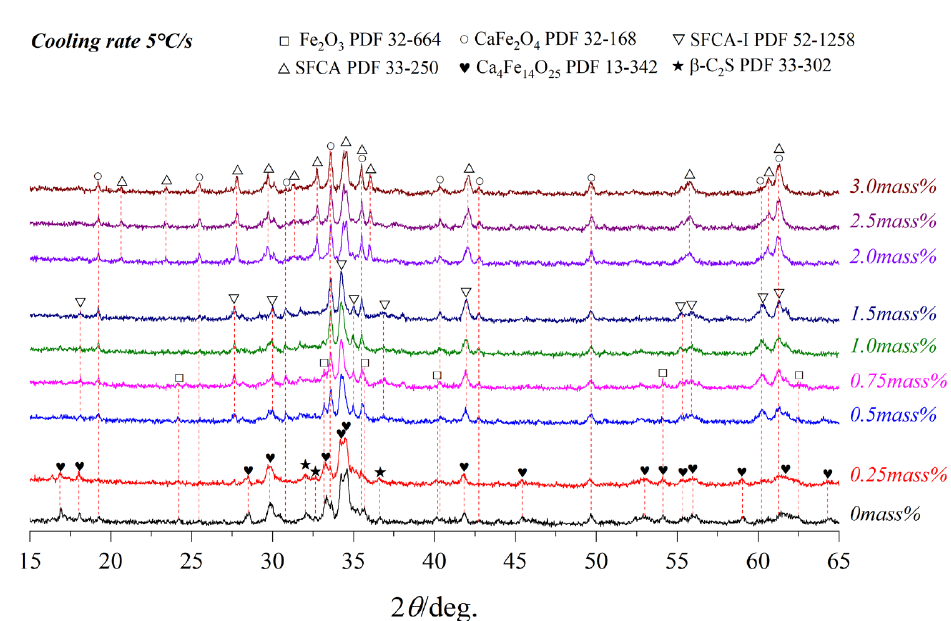
Figure 8. XRD patterns of samples with different Al 2 O 3 content cooled at 5 °C/s.